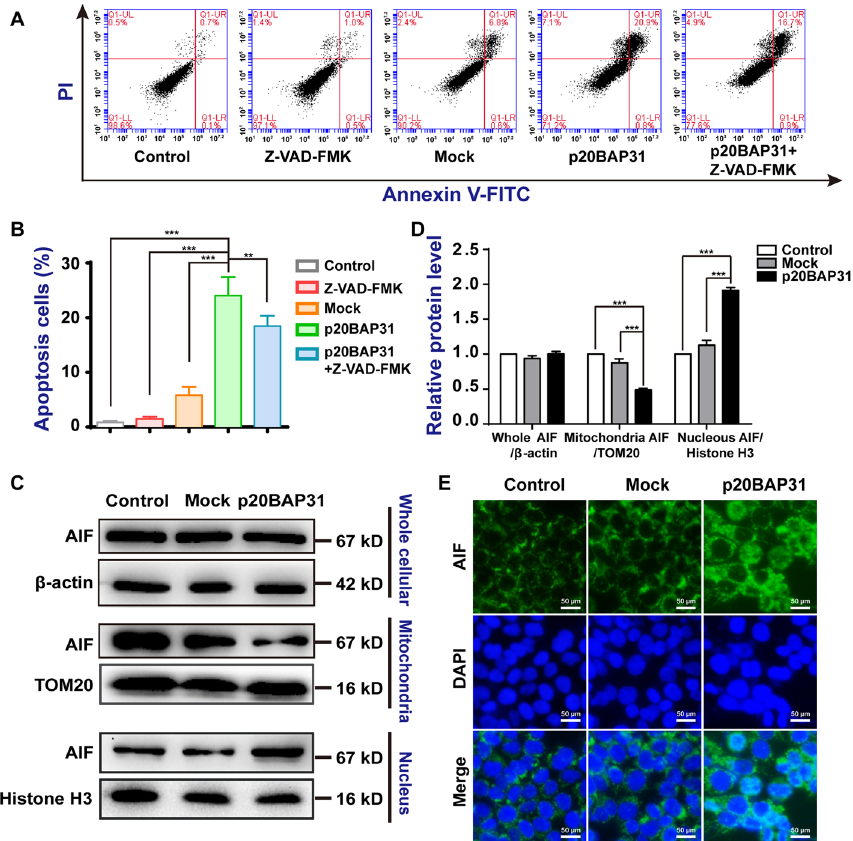
Fig. 7 p20BAP31 induced AIF-mediated caspase-independent apoptosis. A HCT116 cells were pretreated with Z-VAD-FMK (20 μM) before transfection with p20BAP31 for 48 h, and the apoptosis rate was assessed by flow cytometry. B Quantitative analysis of apoptosis rates by flow cytometry. C Western blot analysis detected the protein expression of whole cellular, mitochondria, and nuclear AIF after transfection with p20BAP31 for 48 h. D The relative quantification of the protein levels was analyzed by ImageJ software. E Immunostaining of HCT116 cells was carried out with an anti-AIF antibody and a FITC secondary antibody (green) to localize AIF. Hoechst 33,342 staining (blue) was used to visualize the nuclei, and the merged images clearly demonstrate the nuclear localization of AIF. *** P <